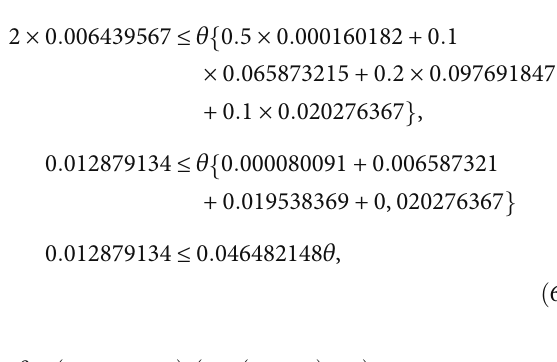
algorithm in the treatment of planning